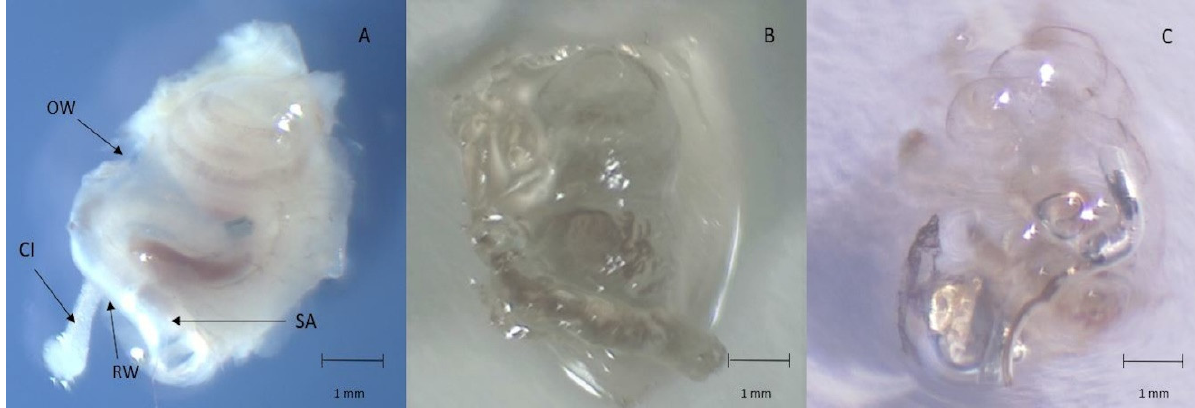
Figure 2. ( A ): fixed and decalcified right cochlea (OW: oval window; RW: round window; SA: stapedial artery; CI: cochlear implant); ( B ): transparent right cochlea outside of the clearing medium; ( C ): transparent right cochlea immerged in the clearing medium (the electrode array in the basal turn of the cochlea is clearly visible). Scale: 1 mm.